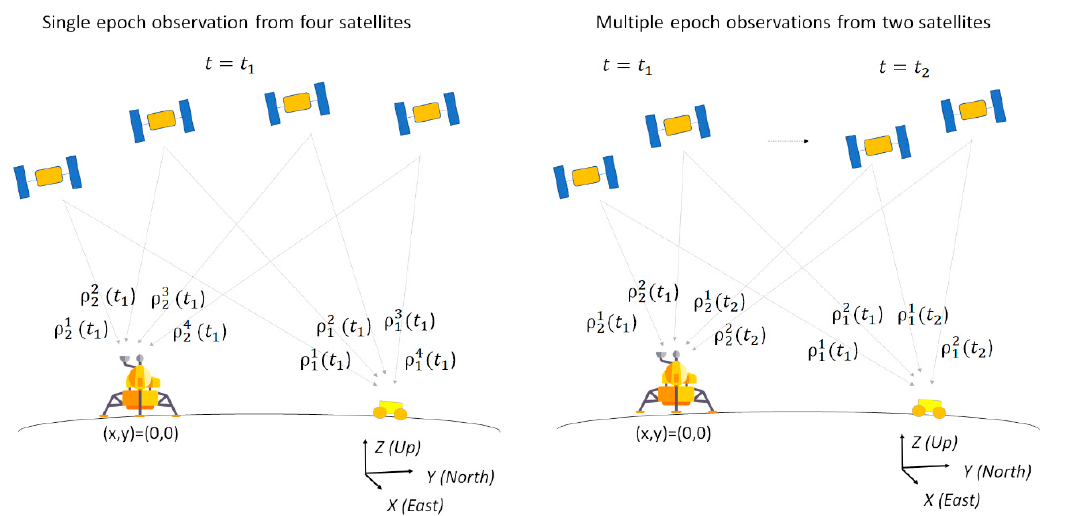
Figure 1. Overview of the MDPO concept in comparison with a conventional pseudorange-based method.